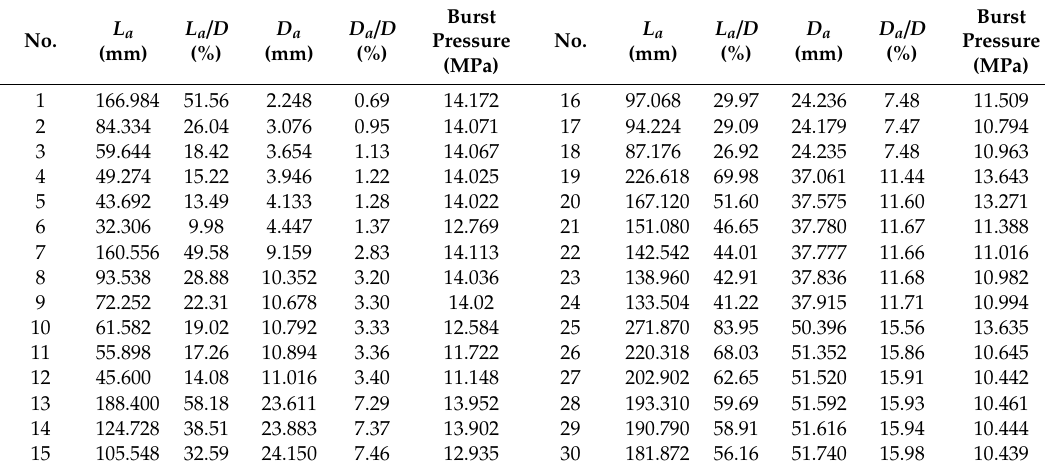
Table A2. La , La / D , Da , Da / D and burst pressure for the FEA based parametric study (II) for X52 material pipelines with a hemispherical dent.